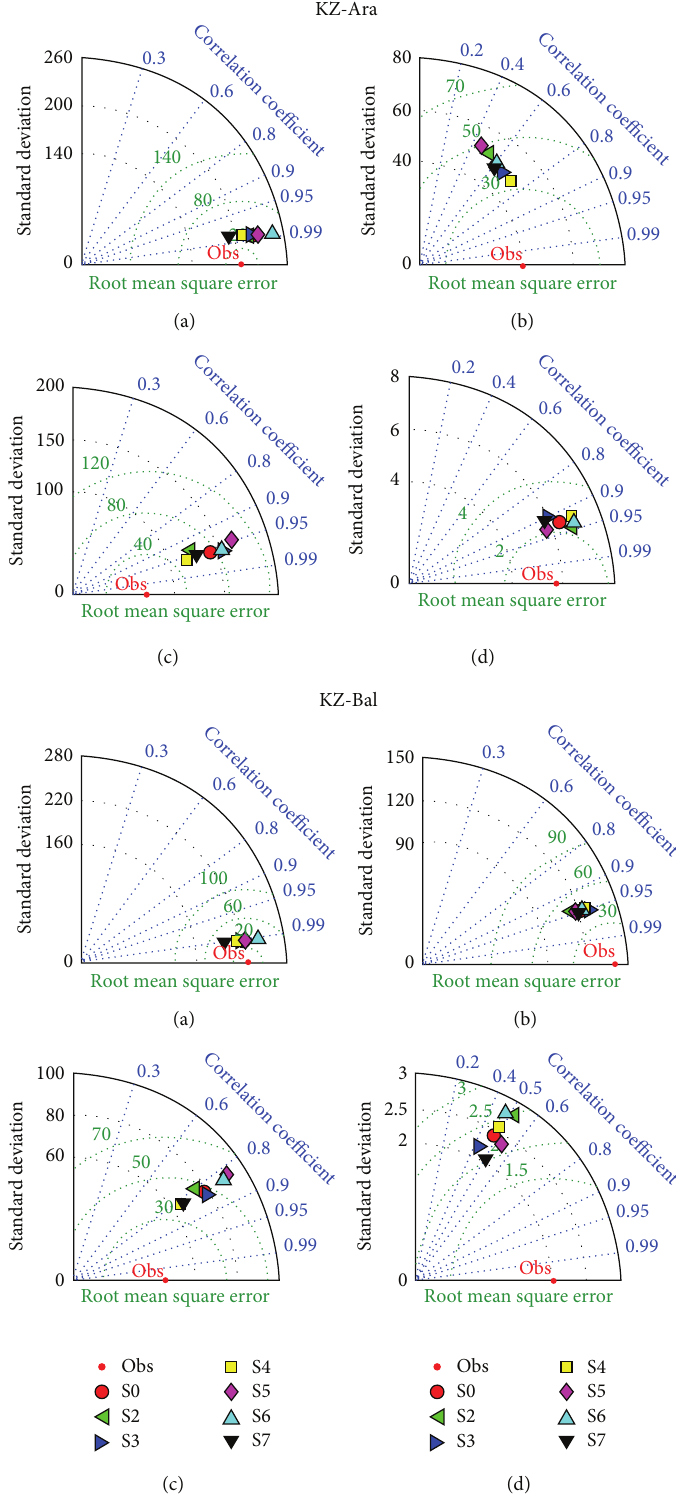
Figure 6: Taylor diagram plot of thesimulated 𝑅 net (a), 𝑄 le (b), 𝑄 ℎ (c), and 𝑇 soil (d) computed froma reference model (S0) and six independent sensitivity tests (S2–S7, see Table 3) from the CoLM against EC observations at the two EC sites. Standard deviation (STD, Wm −2 ) is calculated as the simulated variables divided by the observed data. “Obs” refers to observed data points. Root mean square error (RMSE, Wm −2 ) is represented by green lines. 𝑅 is the correlation coefficient. The higher the 𝑅 and the smaller the STD and RMSE, the better the agreement between model and data. When comparing two simulations with different parameter values, the longer the distance between the two simulation points, the greater the sensitivity to that